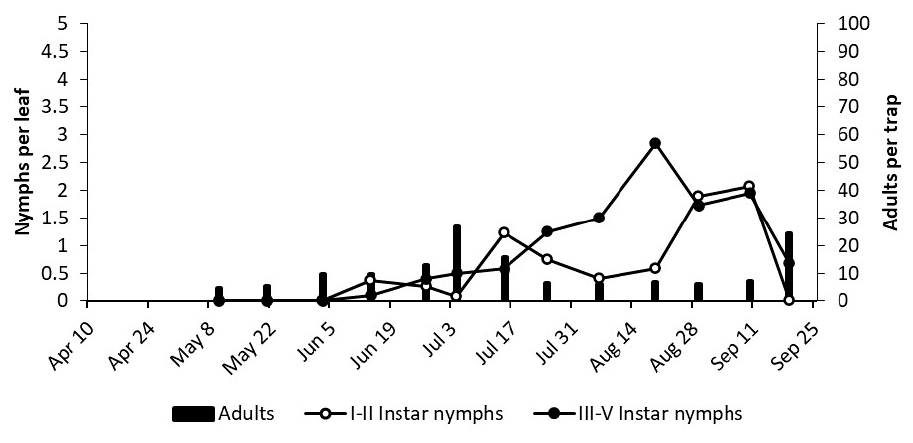
Figure 10. The phenology of E. vulnerata in MO vineyard in the growing season of 2019.